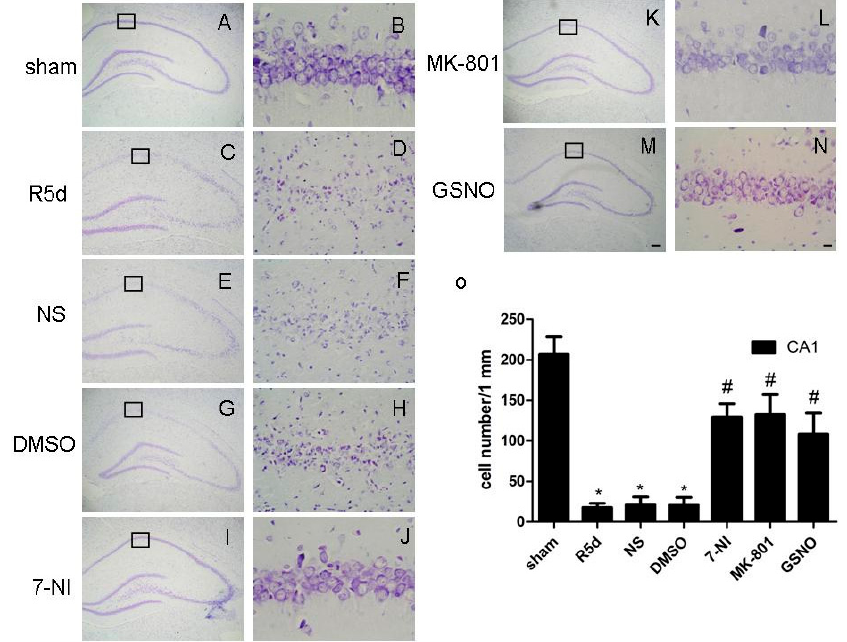
Figure 3. GSNO, MK-801, and 7-NI have neuroprotective roles against injury induced by cerebral ischemia/reperfusion (I/R). Cresyl violet-stained sections from the hippocampi of: sham-operated rats ( A , B ); rats subjected to ischemia and five days of reperfusion ( C , D ); vehicle-treated rats ( E – H ); and rats treated with 7-NI ( I , J ), GSNO ( K , L ), or MK-801 ( M , N ); ( O ) Quantitative analysis of the protective effects of 7-NI, MK-801 and GSNO on the damage to hippocampal neurons after cerebral I/R. Data were obtained from four independent animals, and typical experiment results are shown. Scale bars: left column ( A , C , E , G , I , K , M ), 400 μ m, (magnification 40×); right column ( B , D , F , H , J , L , N ), 10 µ m (magnification 400 ˆ ). * p < 0.05 vs. sham, # p < 0.05 vs. the corresponding solvent-treated control